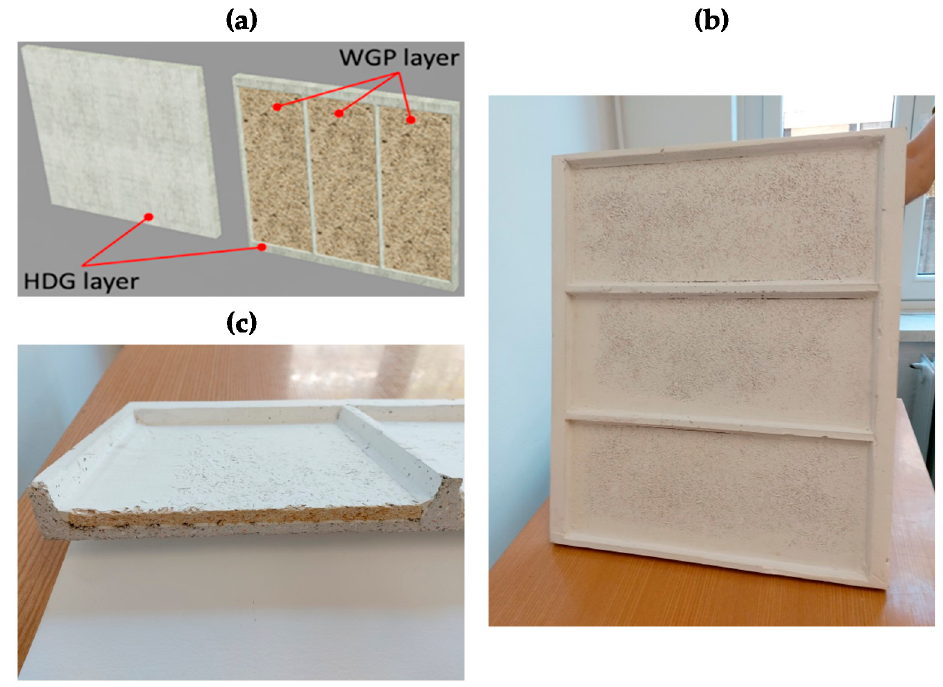
Figure 1. Sketch of the prefabricated geopolymeric façade cladding panel ( a ), developed panel ( b ) and panel cross-section ( c ) (the figure was produced by the authors).